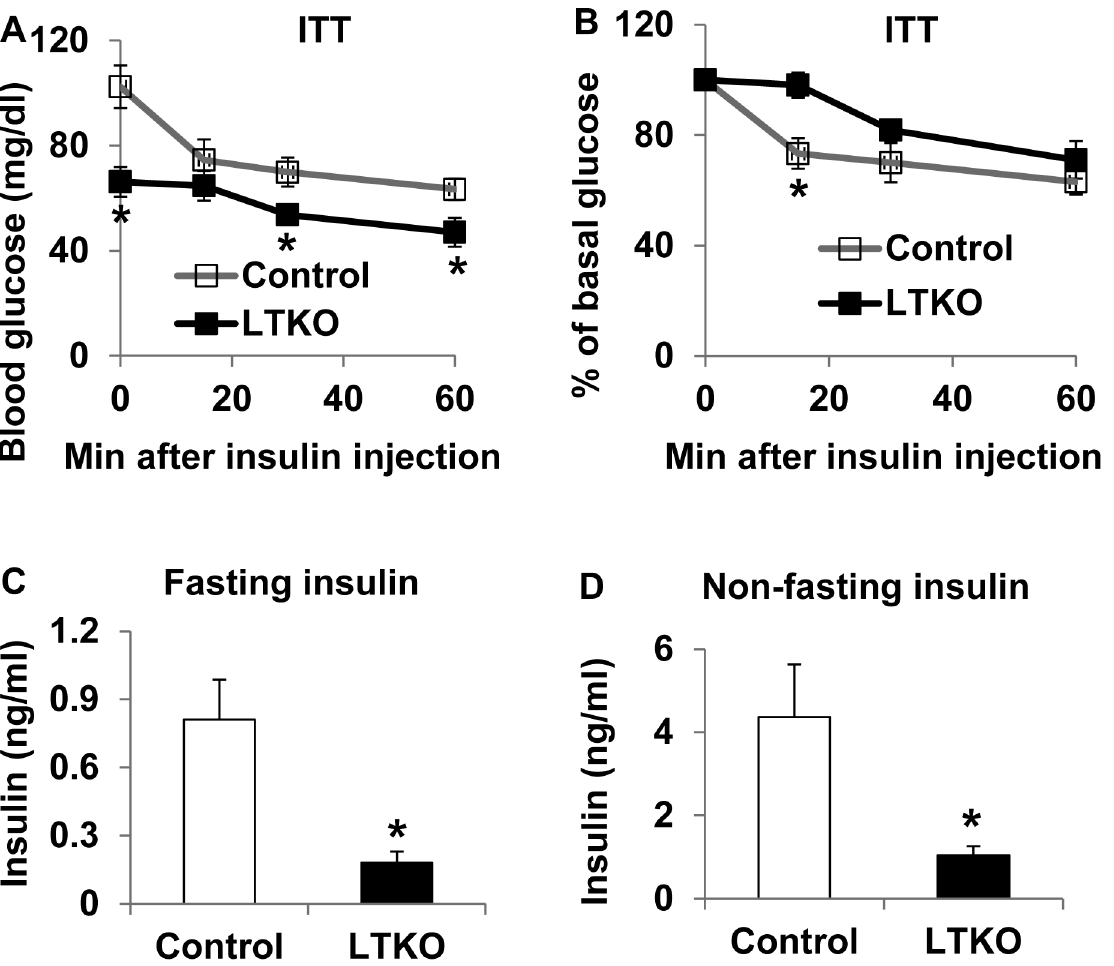
Figure 2. Insulin sensitivity in LTKO mice fed chow diet. (A) Insulin tolerance tests (ITT) in 3-month male control and LTKO mice (n=6) after 3-hour fasting and an intraperitoneal injection of 0.75 U human regular insulin (humulin R, Lilly) per kg body weight. (B) The data in Panel A were replotted as percentage of basal blood glucose as a function of injection time. (C) Plasma insulin levels in 4-month male control and LTKO mice (n=12) after an overnight 16-hour fasting. (D) Plasma insulin levels in 4-month male control and LTKO mice (n=6) under ad libitum conditions. Data represent mean ± SEM. * indicates a significance with P <0.05 in control vs. LTKO